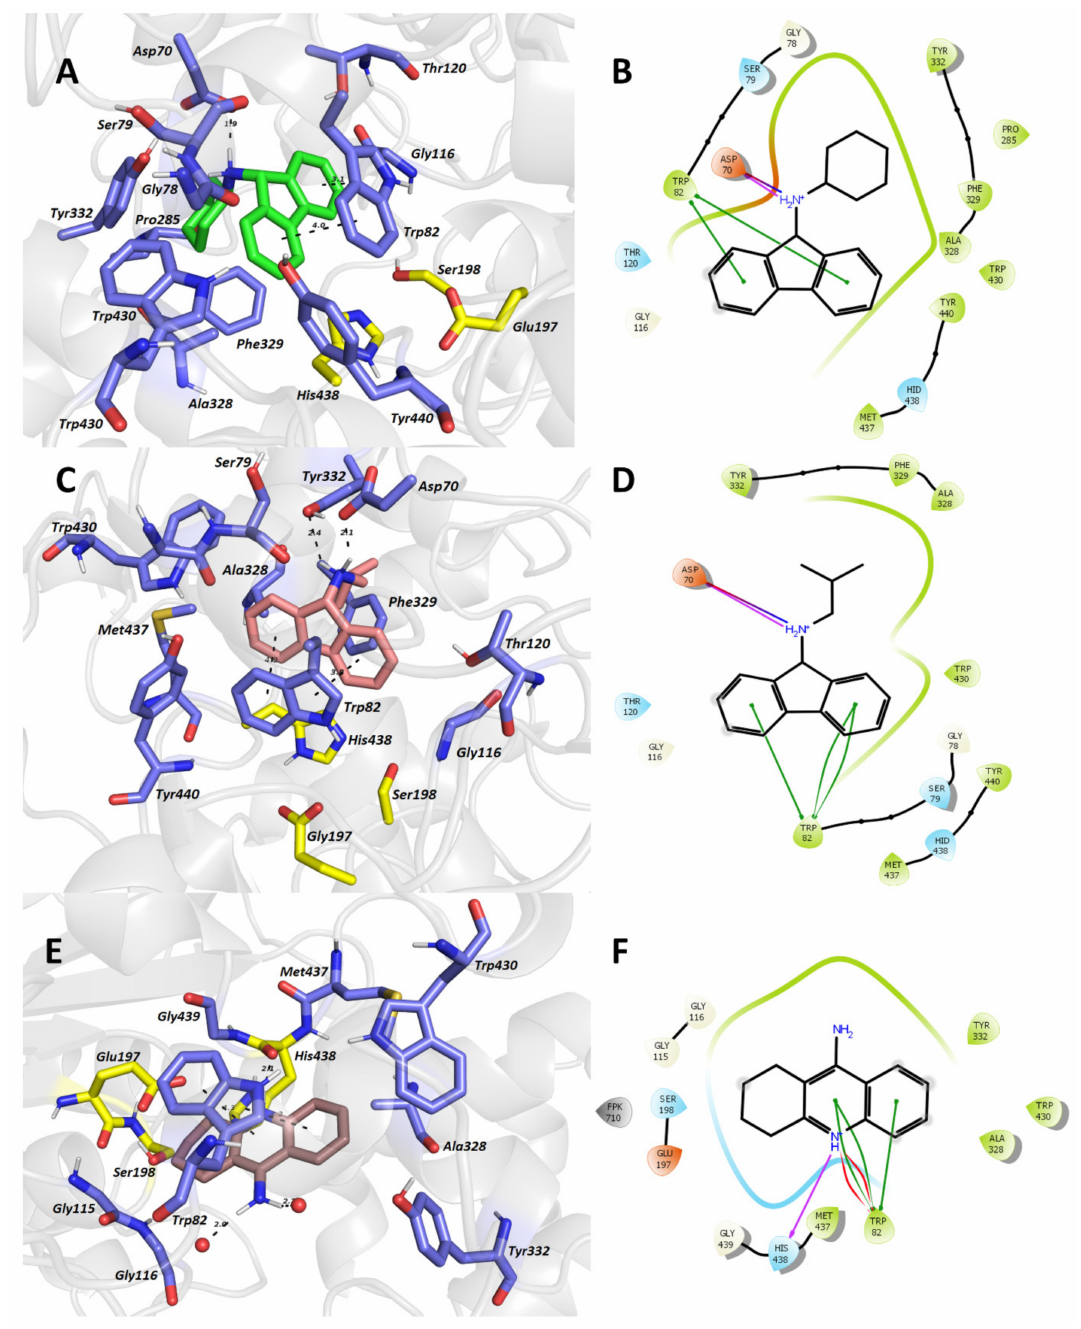
Figure 7. Top-scored docking poses of 3c ( A , B ), 3n ( C , D ), and the crystal structure of THA ( E , F ) within the h BChE active site (Protein Data Bank (PDB) ID: 4BDS) [56]. Ligands are displayed in green ( A ), salmon ( C ), and brown ( E ) for 3c , 3n , and THA, respectively. Important amino acid residues involved in the enzyme-ligand interaction are shown in dark-blue, and the catalytic triad is rendered in yellow. Distances are colored as dashed lines, and the distance is measured in Å ( A , C , E ). 3D figures were created by using PyMOL 2.0.6 viewer. 2D diagrams were generated with Maestro 12.3 (Schrödinger